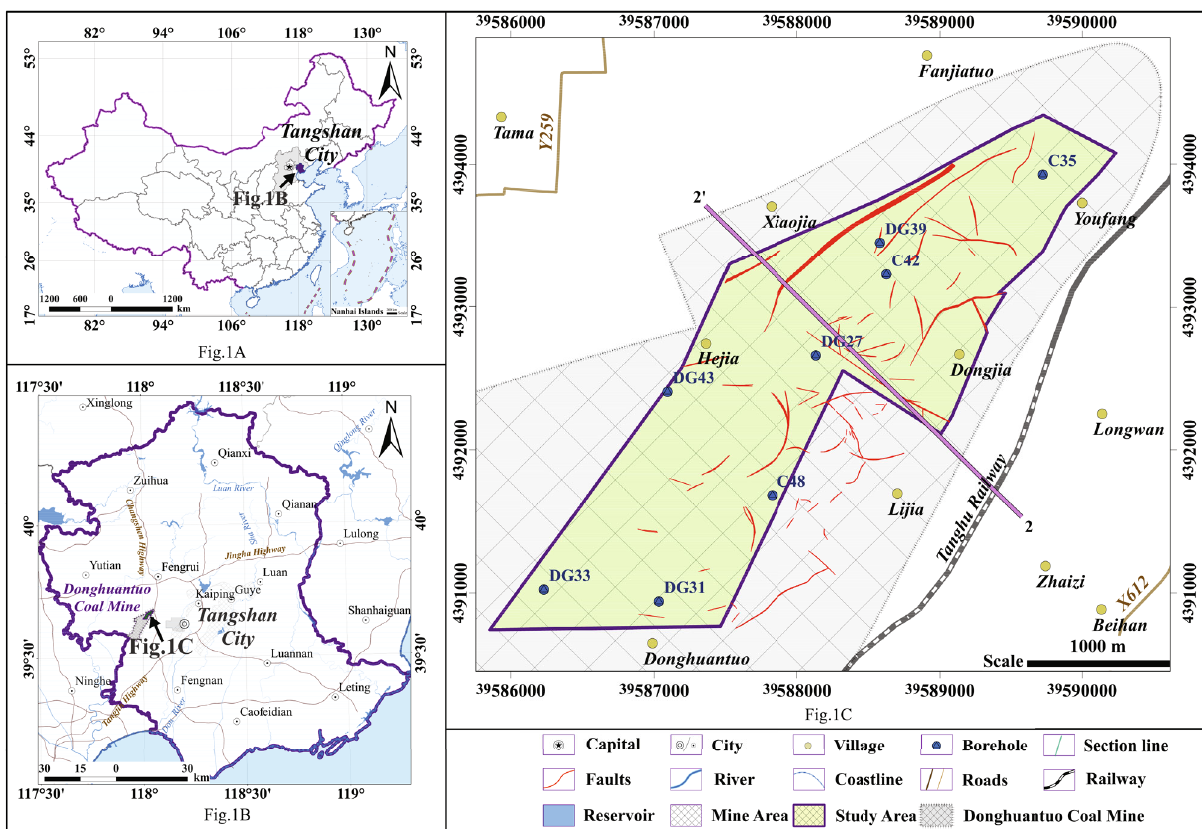
Figure 1: Map showing the location of the study area.